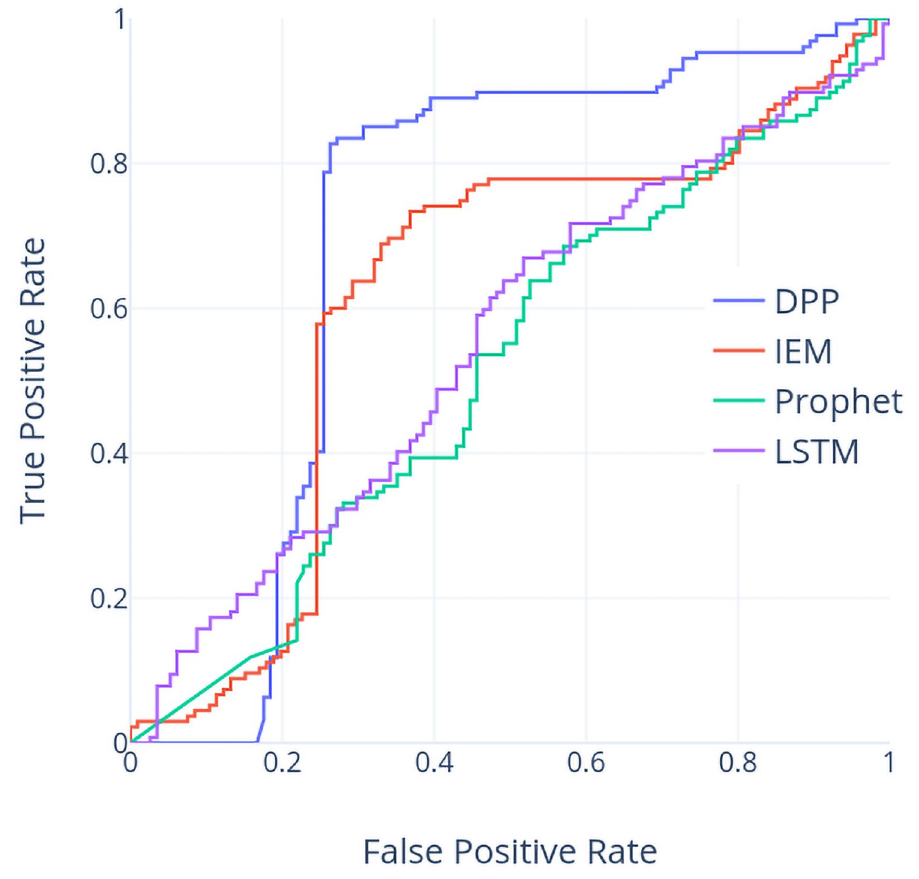
Fig 9. ROC curve (TX